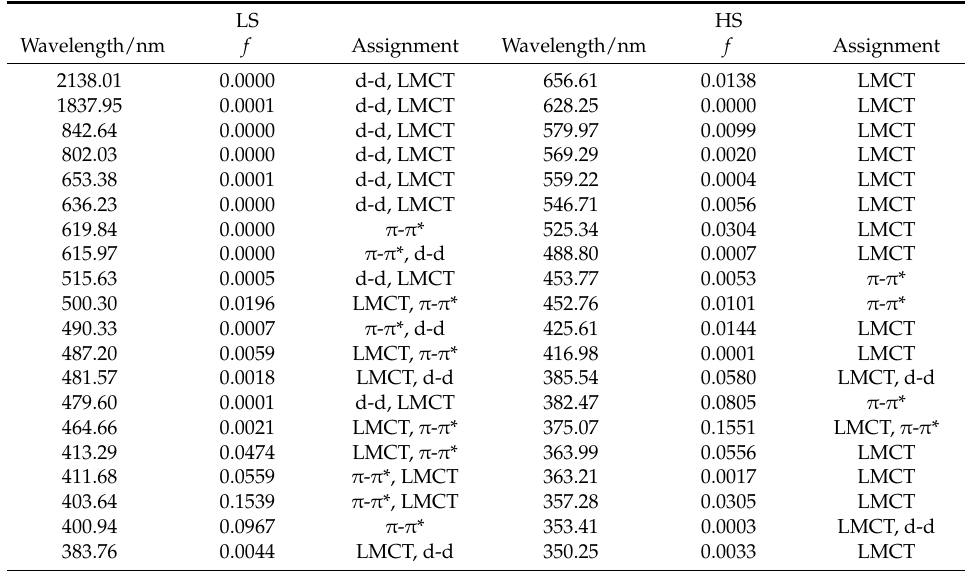
Table 2. Excitation wavelengths, oscillator strengths ( f ), and absorption assignments for the LS [Fe(qsal) 2 ] and HS [Fe(qsal) 2 ]